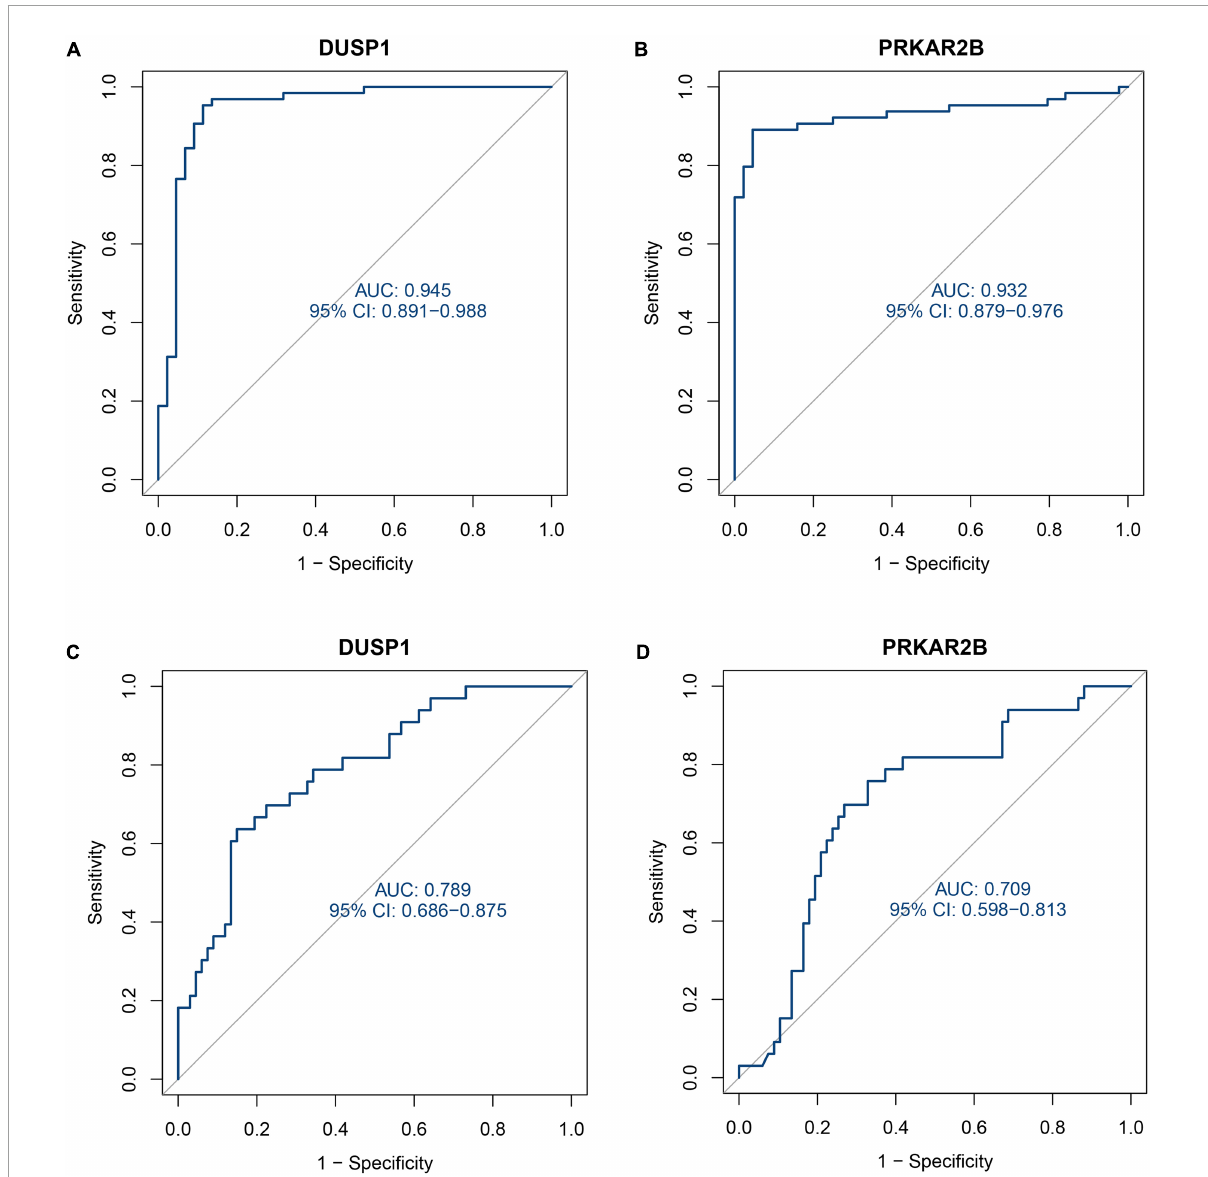
FIGURE5 Receiver operating characteristic (ROC) curves describing the diagnostic efficacy of the two candidate diagnostic marker genes. (A) ROC curve for DUSP1 using the training set. (B) ROC curve for PRKAR2B using the training set. (C) ROC curve for DUSP1 using the validation set. (D) ROC curve for PRKAR2B using the validation